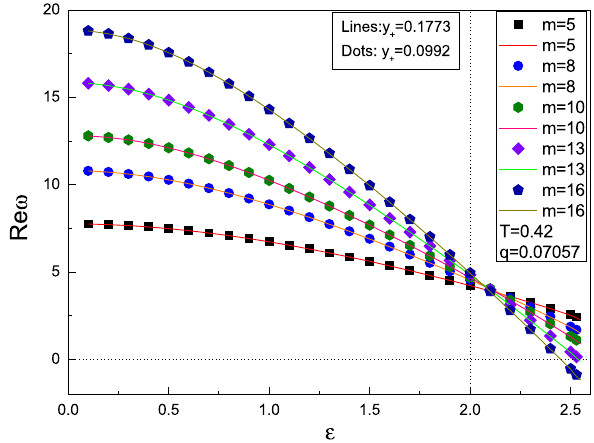
Fig. 9 The real part of frequencies ω against the rotation parameter ε of two small branches for different value of angular quantum number m at T = 0 . 42 and q = 0 . 07057. The black horizontal line represents Re ω = 0. The black vertical line represents ε =